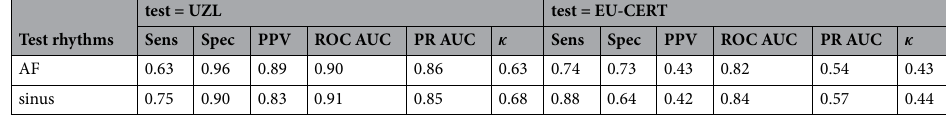
Table 8. Results of the combined model obtained from Experiment 2 in AF signals of both UZL and EU-CERT.